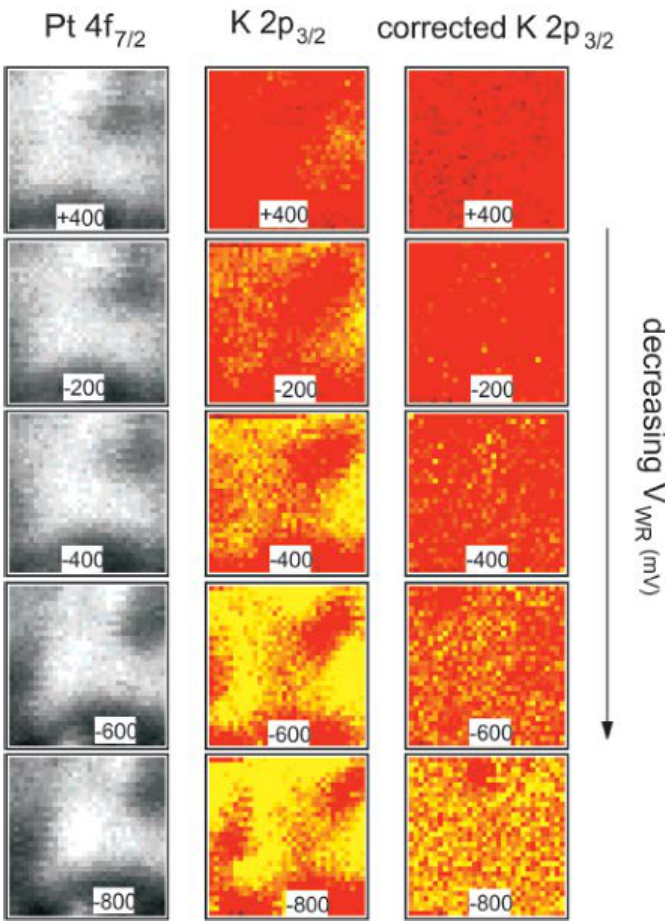
Figure 7. Pt 4f7/2 and K 2p3/2 photoelectron intensity maps taken on a Pt/K- βAl 2 O 3 catalyst as a function of V WR at 473 K during the selective hydrogenation of acetylene. Reprinted with permission from Ref. [38].